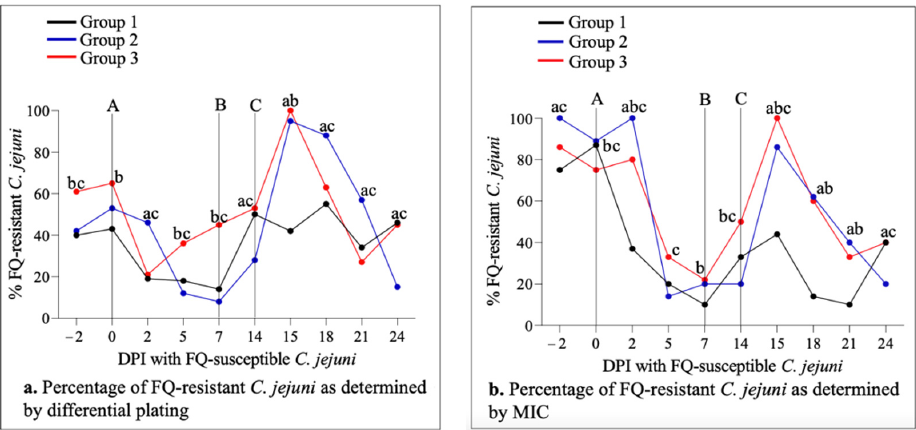
Figure 1. Dot plot graphs showing the colonization level (log 10 CFU/g feces) by total (susceptible and resistant) C. jejuni population ( a , c , e ) and FQ-resistant C. jejuni population ( b , d , f ) in three groups (Group 1, Group 2, and Group 3) of calves. The letter A denotes the time when all animals were orally inoculated (after fecal samples were collected for culture on DPI 0) with FQ-susceptible C. jejuni . The letter B indicates when the calves in Group 3 were challenged (after fecal samples were collected for culture on DPI 7) with M. haemolytica . The letter C represents subcutaneous injection (after fecal samples were collected for culture on DPI 14) with danofloxacin in Group 2 and Group 3. Each dot represents the colonization level in a single calf; the mean colonization levels are indi- cated by horizontal red bars, and vertical red lines represent 95% confidence intervals. The detection limit of the culture was ~100 CFU/g of feces (shown as dotted black lines over the x-axis). DPI: days post-inoculation.